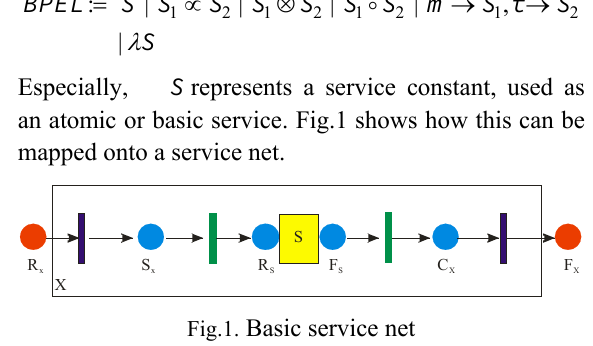
and Z are 1 2 or S , 1 2